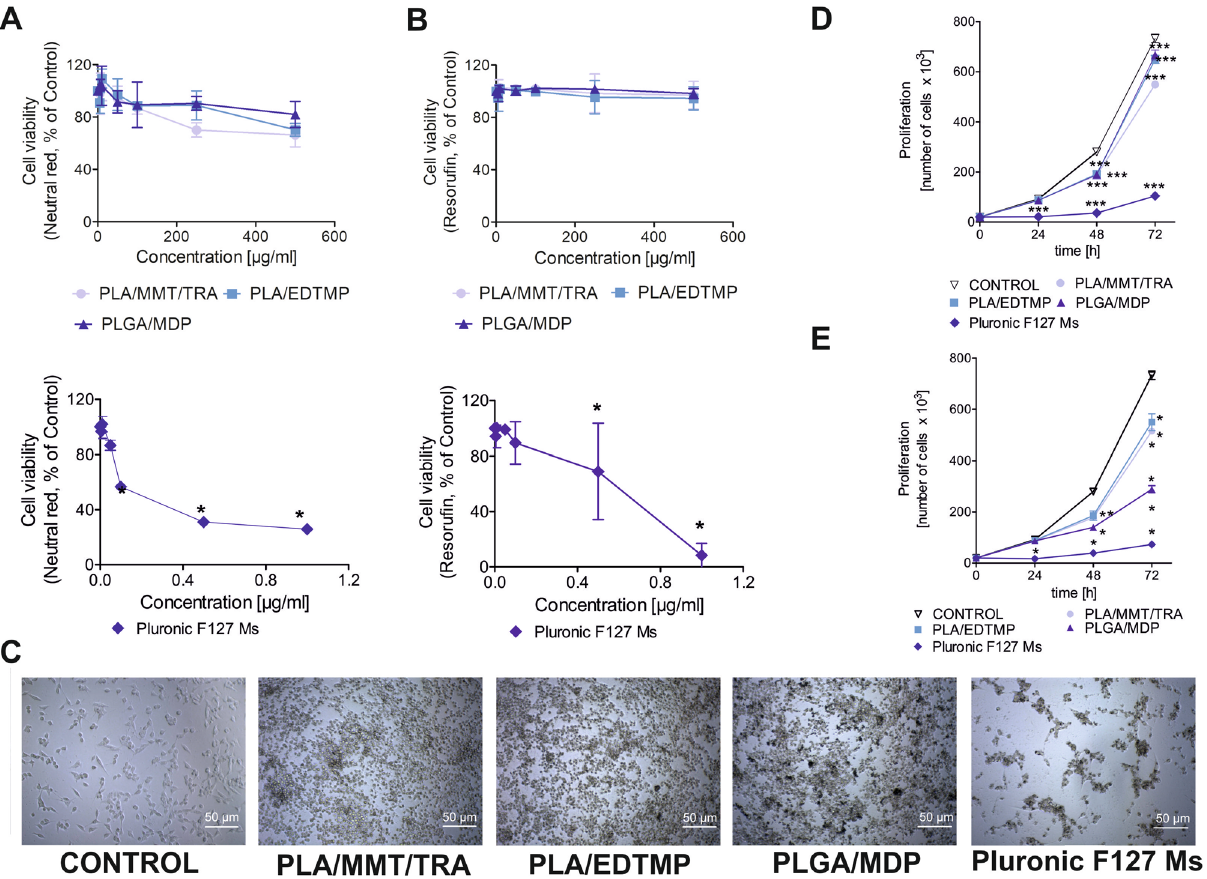
Figure 2. Comparisons of NP cytotoxicity in human endothelial cell line. ( A , B ) HUVEC-ST cell viability measured by the neutral red assay (left panels) or Alamar Blue assay (resazurin oxidation; right panels) after cell incubation for 72 h with increasing concentrations of NPs. Values are the mean ± SD of three independent experiments with six replicates in each experiment. Statistically significant differences comparing control cells taken as 100%, *p < 0.05 ( C ) Light microscopy images under contrast phase conditions of HUVEC-STs after treatment for 24 h with 100 μg/mL of PLA/MMT/TRA, PLA/EDTMP, PLGA/MDP, or 0.025 μg/mL of Pluronic F127 Ms. Bar = 50 µm. ( D , E ) Growth kinetics of HUVEC-STs treated with PLA/MMT/TRA, PLA/EDTMP, PLGA/MDP [100 μg/mL ( D ) or 250 μg/mL ( E )], or Pluronic F127 Ms [0.25 μg/mL ( D ) or 0.5 μg/mL ( E ) for 72 h. ***p < 0.001, values are % of those obtained for untreated control (mean ± SD; n ≥